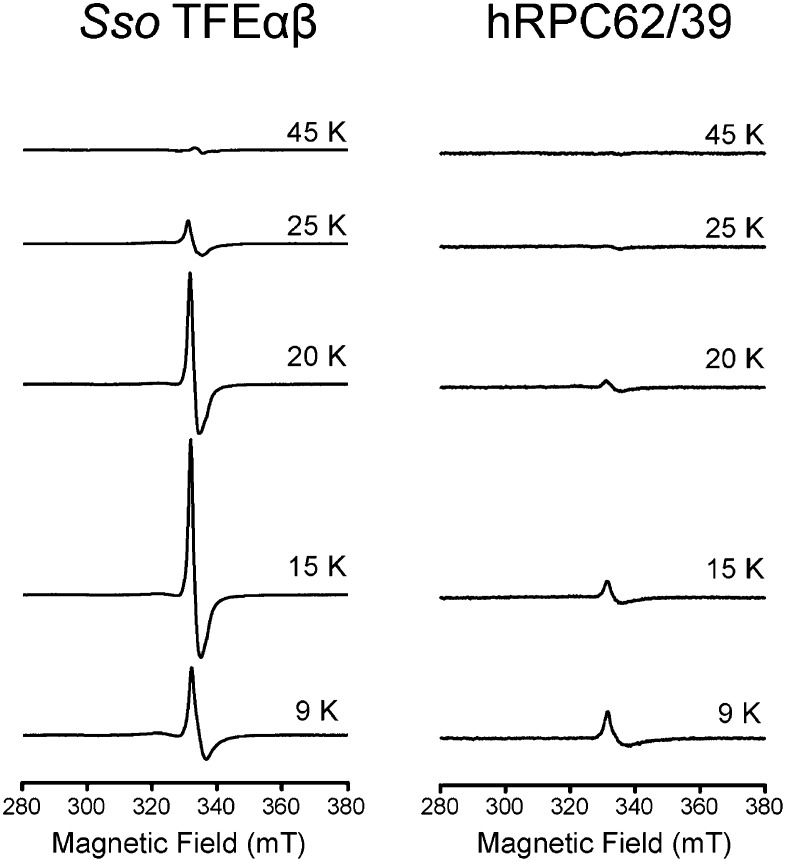
Temperature dependence of the cw-EPR spectra of Sso TFEαβ and hRPC62/39.The decrease in signal at temperatures above 20 K is characteristic of cubane-like FeS clusters.